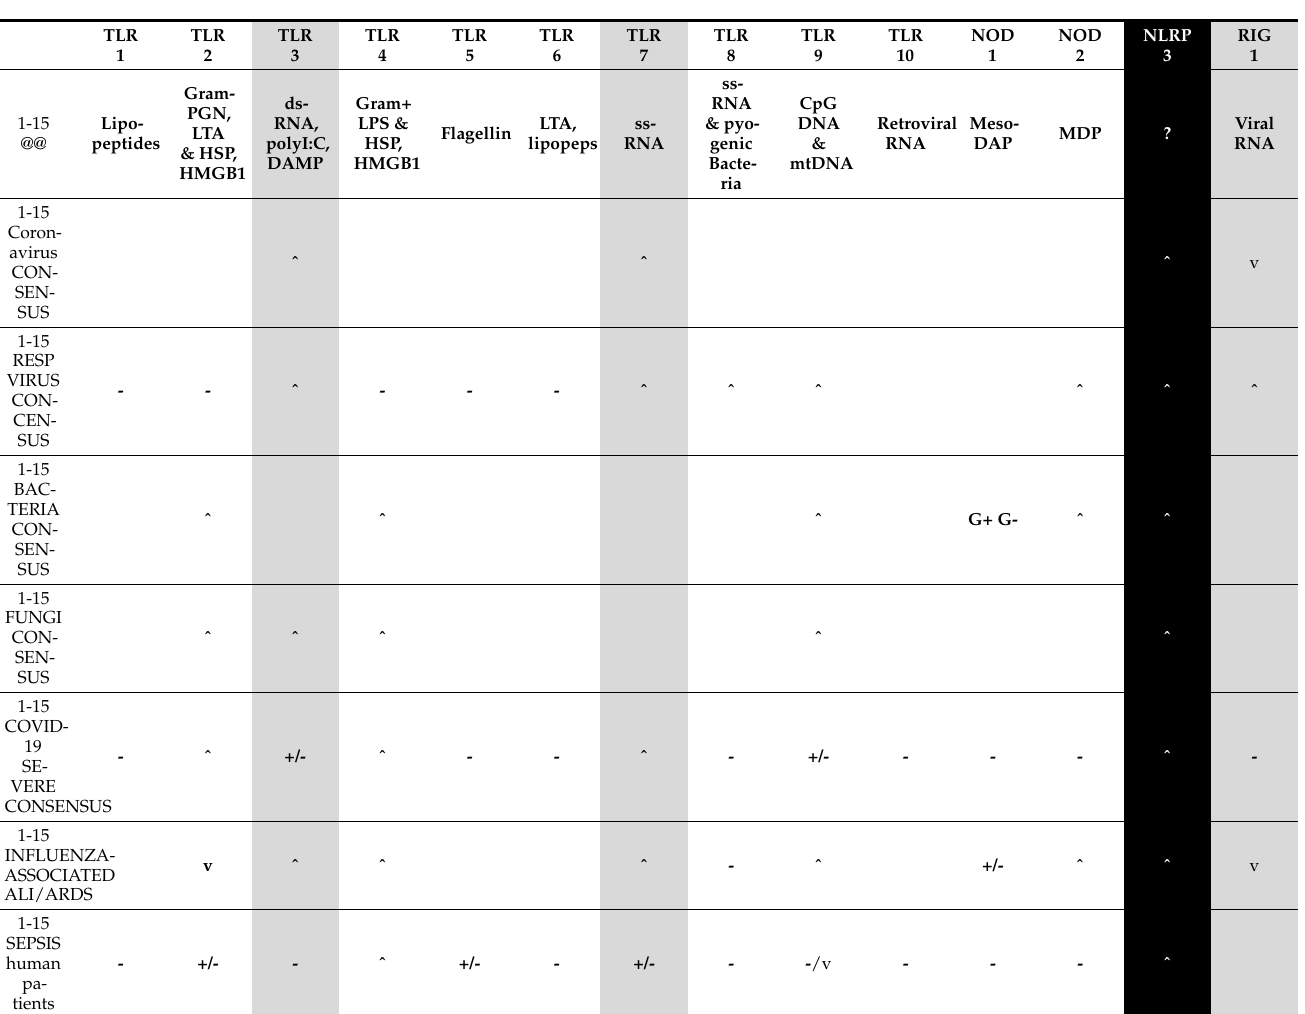
Table 5. Summary table of the consensus activation patterns of microbes derived from the previous Tables 1–4. TLR and NLR columns in white are those activated mainly by bacterial and fungal PAMPs; columns in grey are those activated mainly by virus PAMPs. Only NLRP3 (black boxes with white symbols) is activated by all of the pathogens and is upregulated in all of the cytokine storm-related diseases listed here. The G+G- symbol under NOD1 for the bacterial consensus represents the fact that Gram-positive bacteria do not activate NOD1 but Gram-negative bacteria do. – indicates no change, ˆ indicates increased activation or protein expression, V indicates downregulation or decreased protein expression, +/- indicates conflicting reports about whether there is increased activity or protein expression, -/V indicates conflicting reports about whether there is no change or downregulation and a blank square indicates no available information. See Table 1 for the rest of the